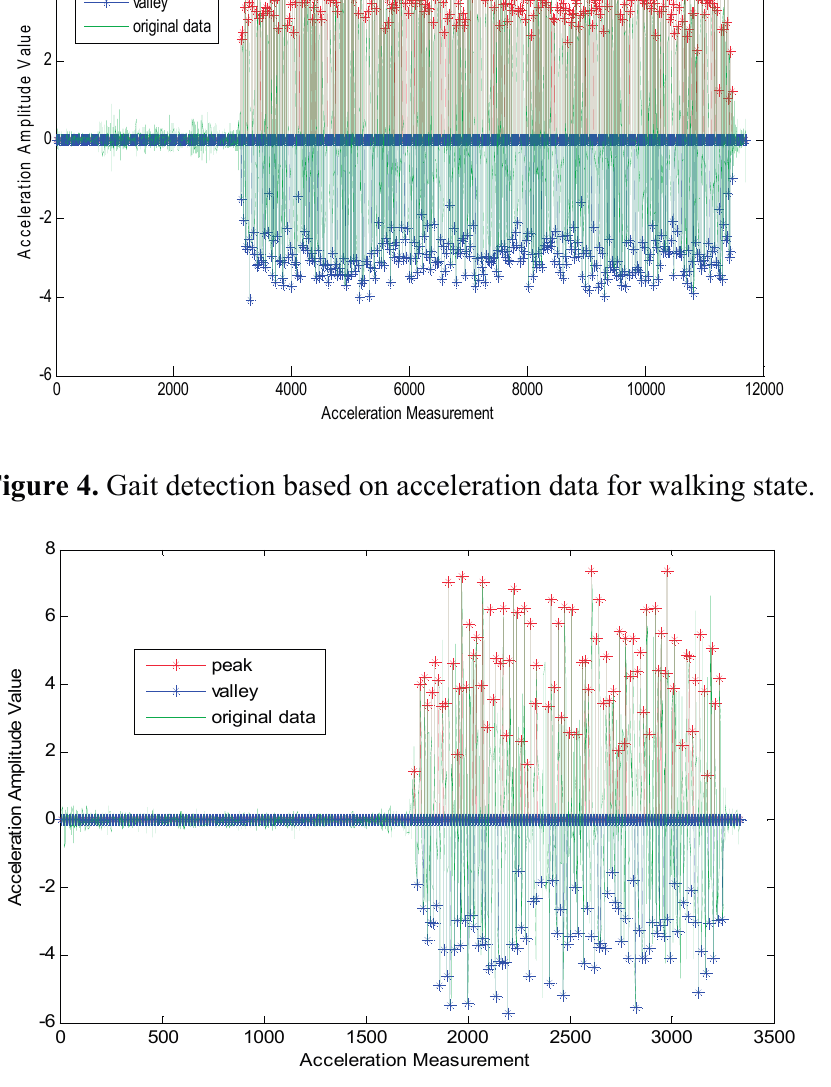
Figure 5. Gait detection based on acceleration data for running